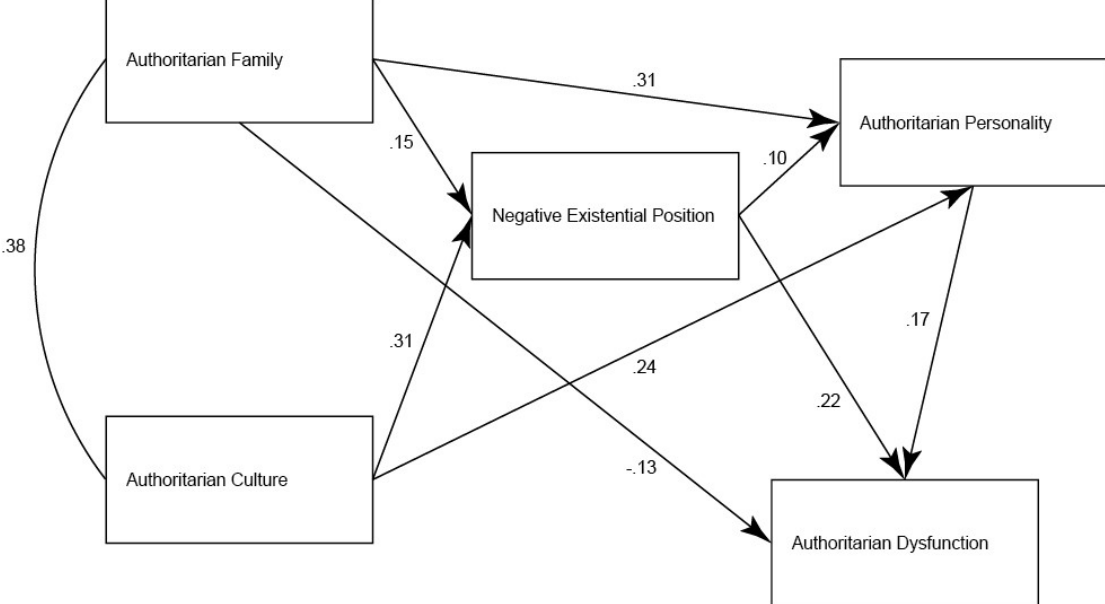
Figure 8: Relationship among the Predictors of the Authoritarian Personality and their Impact on Acculturation Dysfunction (with standardized coefficients for the Immigrants’ Total Sample, N =